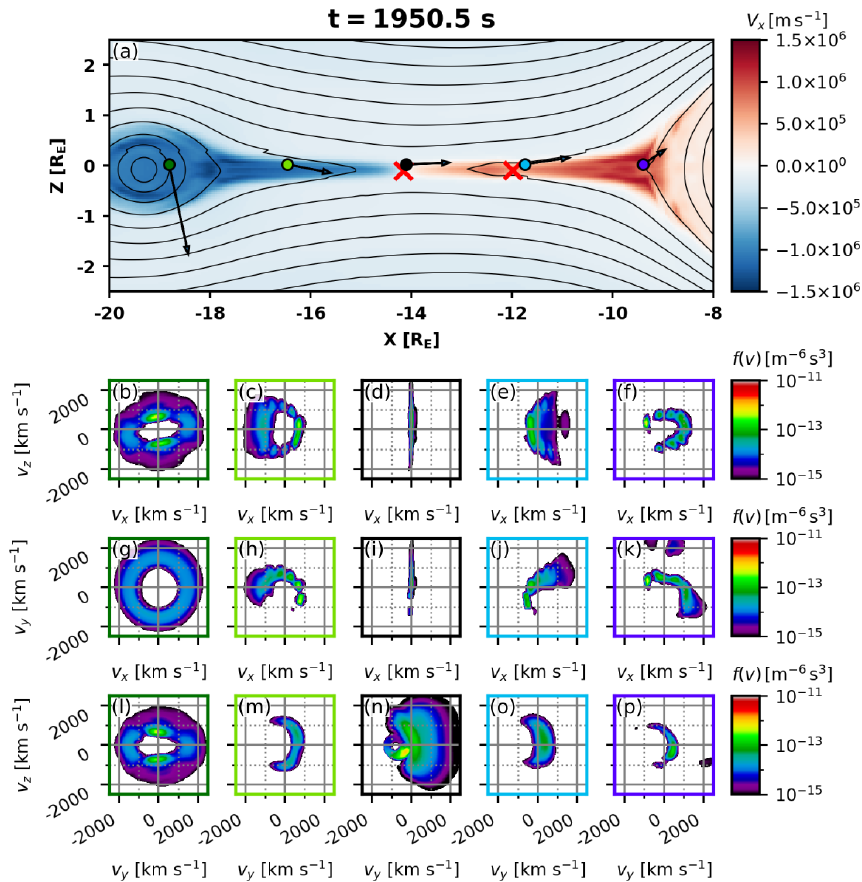
Figure 6. (a) X component of the plasma bulk velocity in the magnetotail at t = 1950 . 5s in the same format as in Fig. 2 with magnetic field lines, X point locations, five virtual spacecraft, and the magnetic field projection in the XZ plane at their locations. Slices of the 3D VDFs (velocity distribution functions) at the five locations indicated with colored circles are shown in the (b–f) { v x , v z } plane, (g–k) { v x , v y } plane, and (l–p) { v y , v z } plane. The VDFs are shown in the plasma